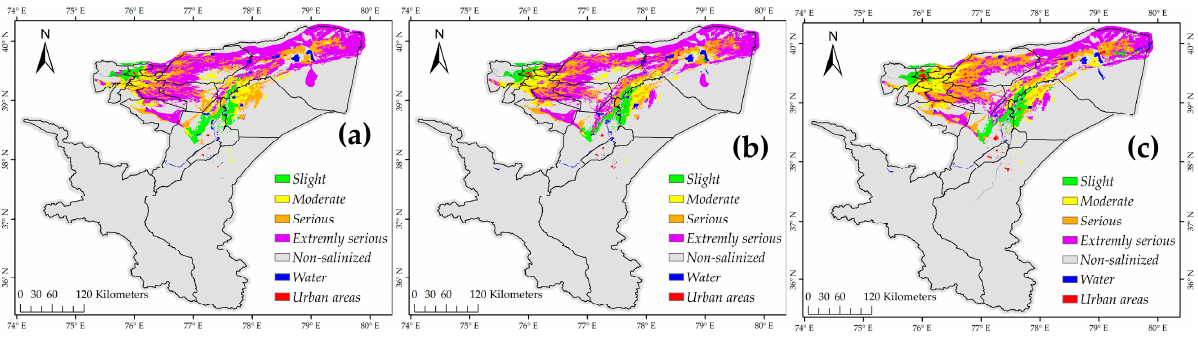
Figure 3. Distribution of soil salinization in the Kashgar region in 2000 ( a ), 2010 ( b ), and 2017 ( c ). It can be seen from Figure 3 that the salinized soil in the Kashgar region was mainly on the plain and concentrated in the two irrigation areas of the Yarkand River Basin and Kashgar River Basin. There was almost no salinized soil in the Tashkurgan Taji autonomous county, Zepu county, and Yecheng county, which were located at the upper and middle reaches of the Yarkant River Basin. Slightly and moderately salinized soils were mainly distributed in Shufu county, Shule county, and Kashgar city where Kashgar River flows through, and in Shache county and Maigaiti county where Yeerqiang River flows through. Severely and extremely severely salinized soils were mainly distributed in the Yingjisha county, Jiashi county, Yuepuhu county, and Bachu county. The severity of salinization changed along the longitudinal profile of rivers, and the severity was gradually getting worse from the upstream to the downstream in the Yeerqiang River and Kashgar River. Meanwhile, the severity of salinization also changed with the distance from the main river channel, soils near the main channel were mildly salinized, and the severity of salinization was worse for soils farther away from the main channel. The spatial pattern of soil salinization change was also closely related to the position of rivers when comparing the soil salinization maps for three different periods. The slightly and moderately salinized soil expanded to the downstream area, and the area of extremely severely salinized soil decreased during the study